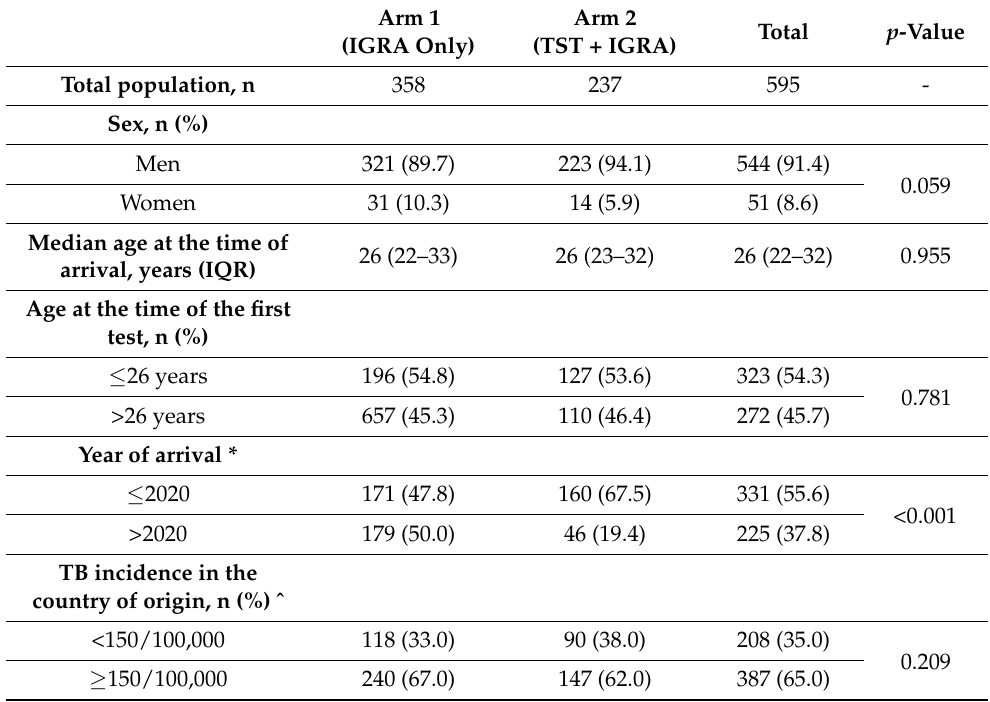
Table 1. Characteristics of study